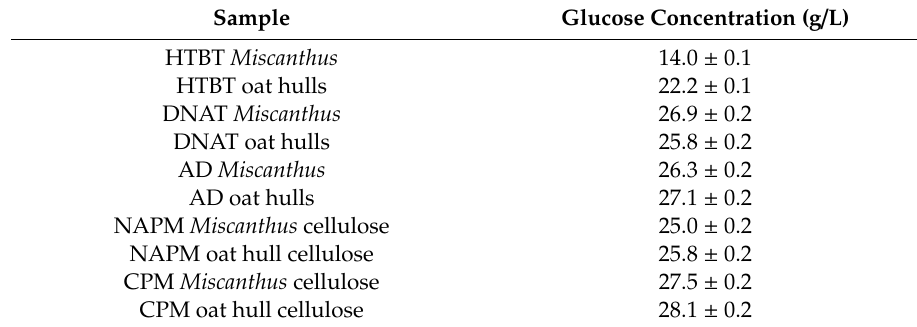
Table 3. Glucose concentrations in hydrolyzates obtained after 72 h of enzymatic hydrolysis (aqueous medium).